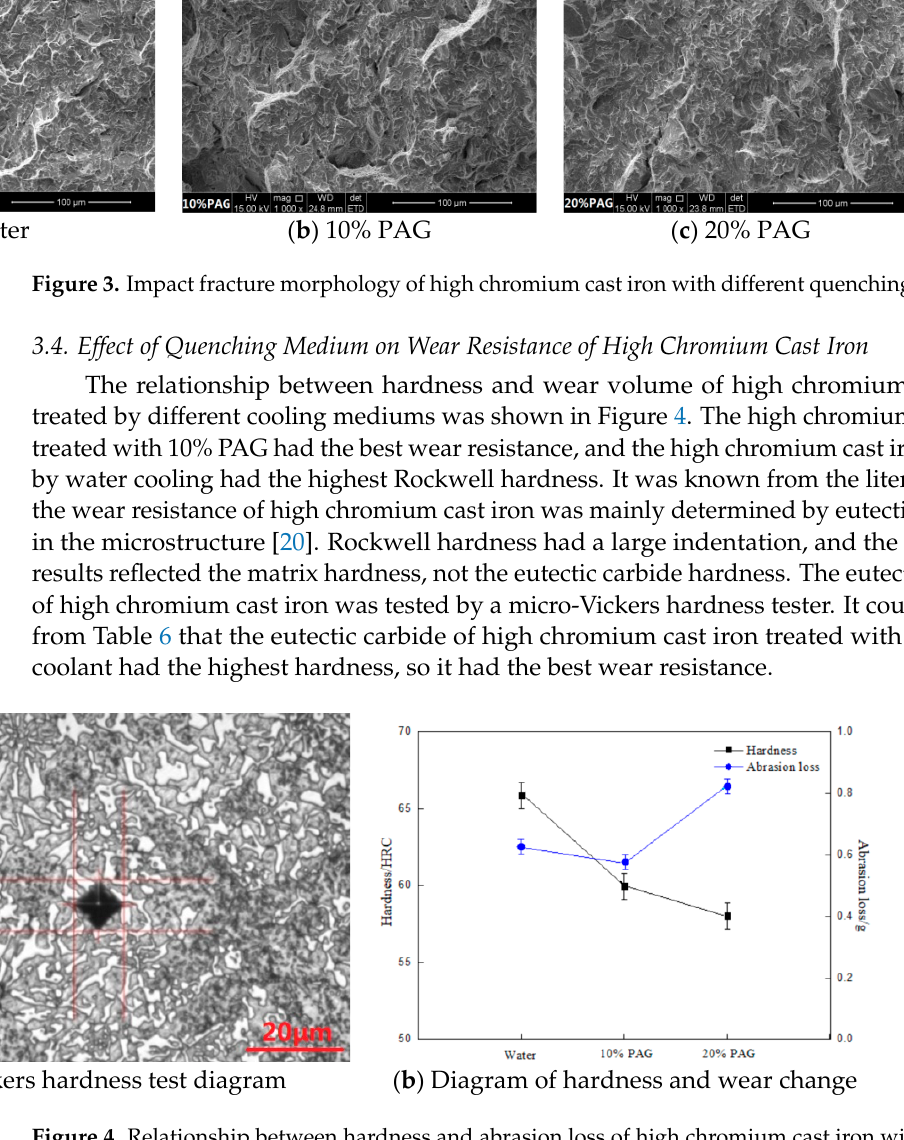
Table 5. Influence of quenching medium on the toughness of high chromium cast iron.